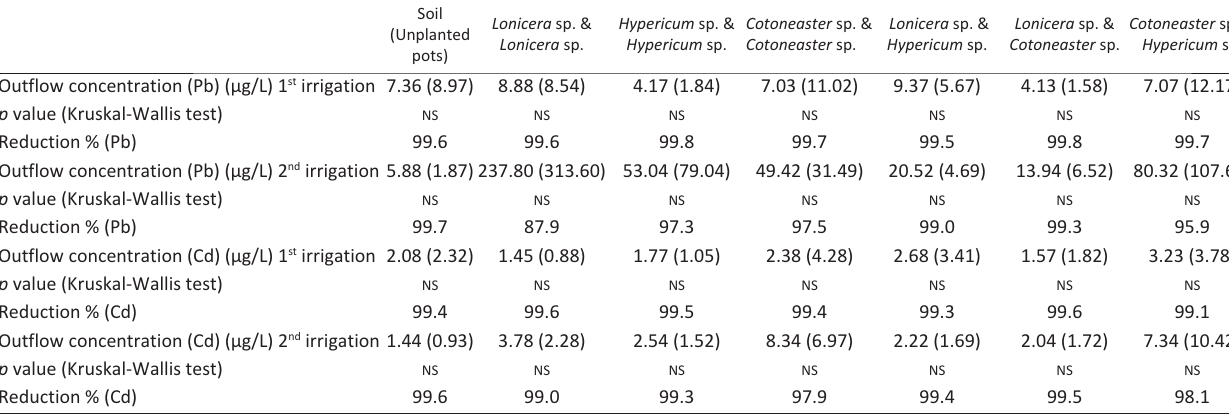
Standard deviation in brackets. Kruskal­Wallis test; significant at p<0.05.